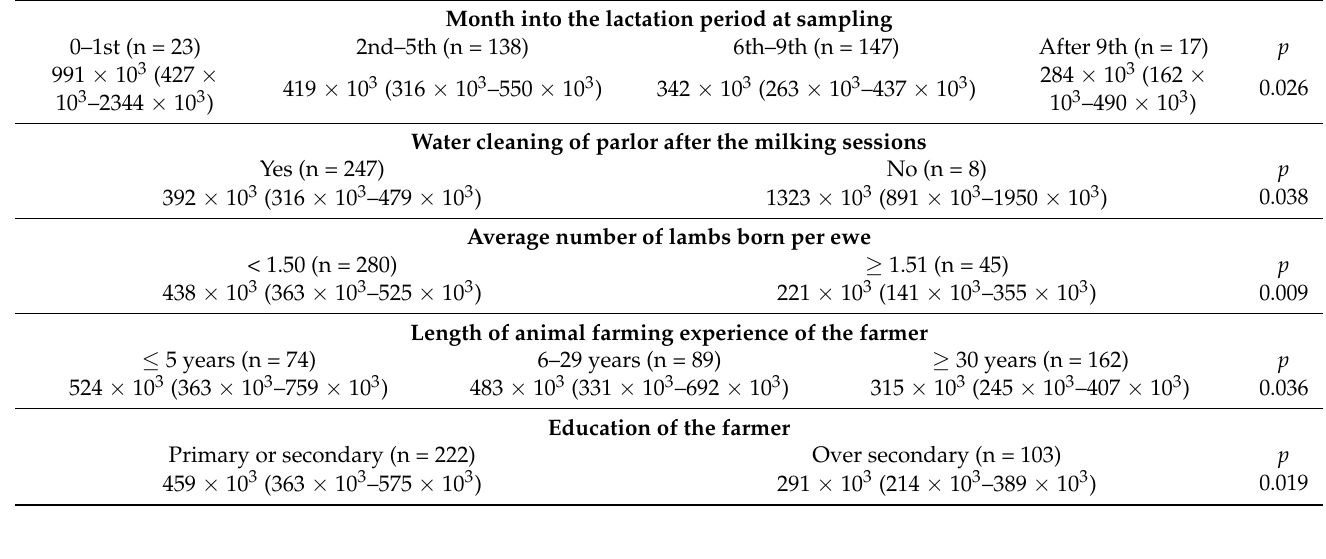
Table 6. Factors (n = 5) with significant variations between their categories with regard to total bacterial counts (geometric mean [95% confidence intervals] cfu mL − 1 ) in the bulk-tank milk of 325 sheep flocks in Greece.